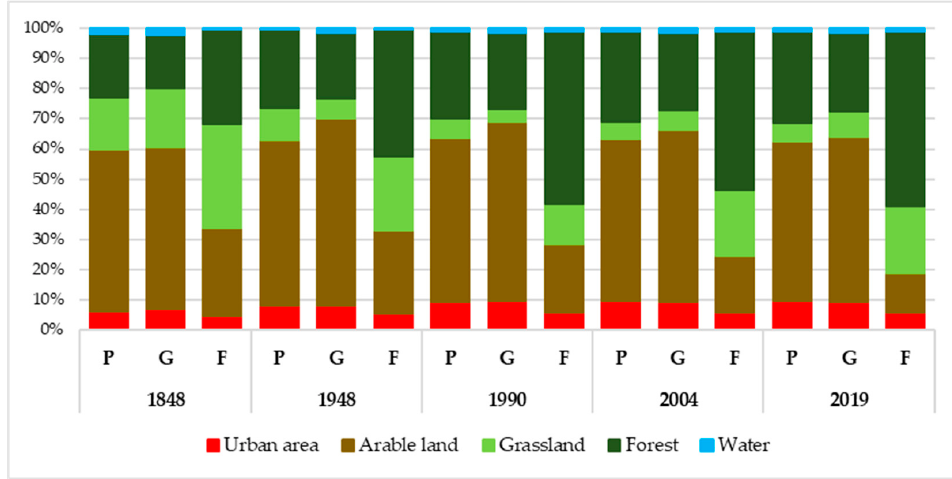
Figure 5. Average percentage values of land use categories represented by region of production (P—potato, G—grain, F—forage) for individual years based on an analysis of the actual land use. The category of permanent grassland has long been present (since 1948) in this group decreasing during the period under review. The average percentage is around 6.51%. A